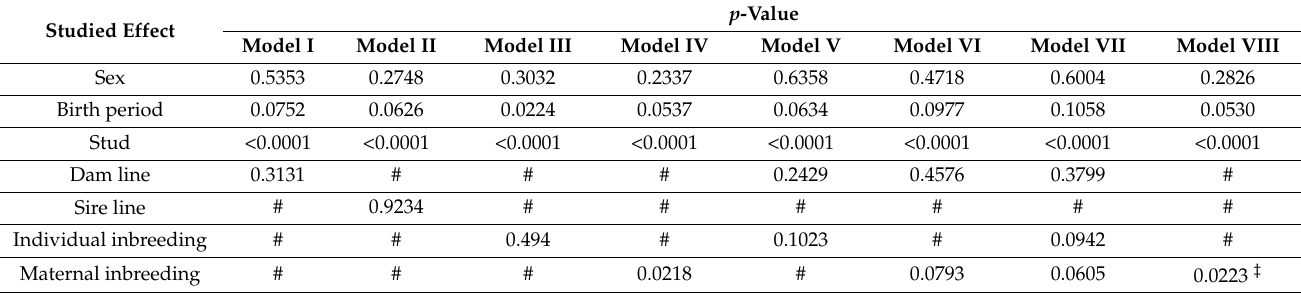
Table 4. Results of statistical analyses of studied factors of asthma morbidity in logistic regression models. Studied